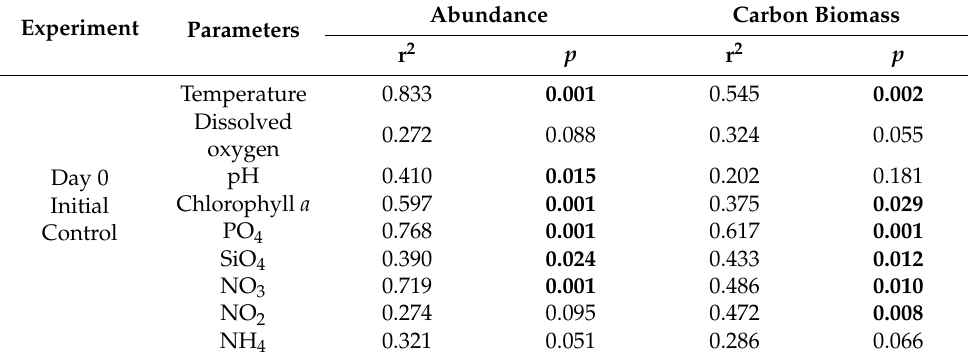
Figure 3. NMDS ordinations of microplankton and significant environmental correlates of taxa abundances ( left ) and biomasses ( right ) for Day 0 initial control samples. Panel A stress = 0.085. Panel B stress = 0.136. Table 2. Spearman correlation values (r 2 ) and permutation-based p -values between explanatory variables and microplankton assemblage square-root taxa abundances and log(x + 1) biomasses of Day 0 Initial Controls (ambient conditions) for all experiment months. Statistically significant p -values are in